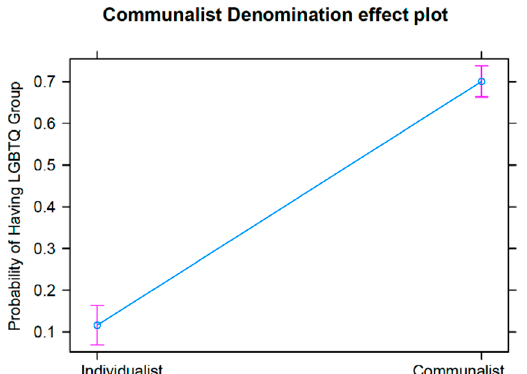
Figure 1. Predicted probability of a Christian college or university having an LGBTQ student group, by affiliation with a communalist vs. individualist religious tradition . Table 2. Logistic regression analyses of LGBTQ groups at Christian colleges and universities.